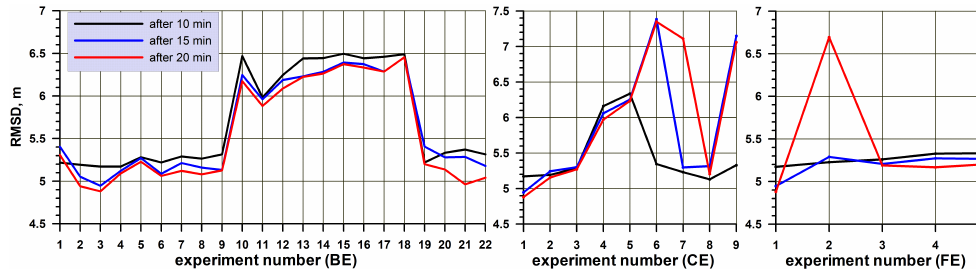
Figure 3. Cumulated deviations (RMSD) for 22 coastal observations (Figure 2) for three-time intervals, 10, 15 and 20 min. Left panel—basic experiments (BE, Table 2); middle panel—correction experiments (CE, Table 3); right panel—final experiments (FE, Table 4).